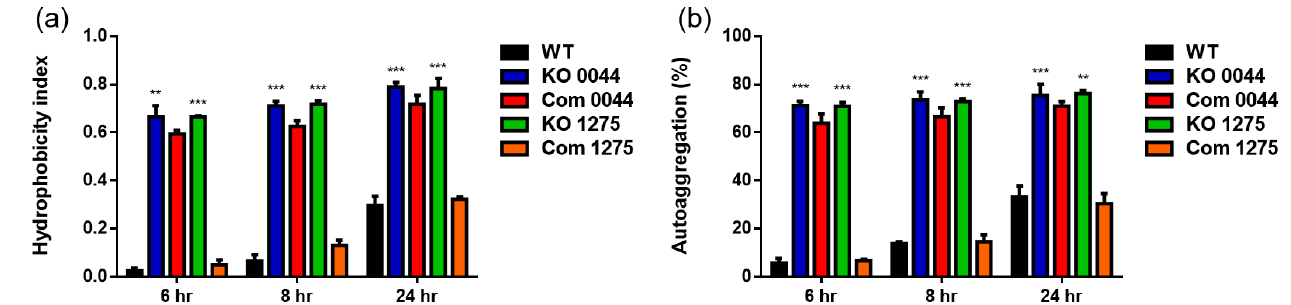
Figure 5. Effects of the HP0044- and HP1275 -disrupted mutations on the membrane properties of H. pylori . Various H. pylori strains were incubated with ( a ) an organic solvent, n-hexadecane, for the surface hydrophobicity analysis, and ( b ) phosphate-buffered saline (PBS) for the autoaggregation assay. The hydrophobicity index and autoaggregation percentage, representing the cell surface hydrophobicity and bacterial autoaggregation, respectively, were calculated from the OD 600 values recorded at different time points of the corresponding experiments, as described in the Materials and Methods section. The OD 600 value obtained from the zero time point served as a control for background subtraction. Data presented are derived from triplicate trials with statistical analysis (unpaired, two-tailed Student’s t -test; ** p < 0.01 and *** p < 0.001). WT, wild-type strain; KO, knockout mutant; and Com, knockout complementary mutant.